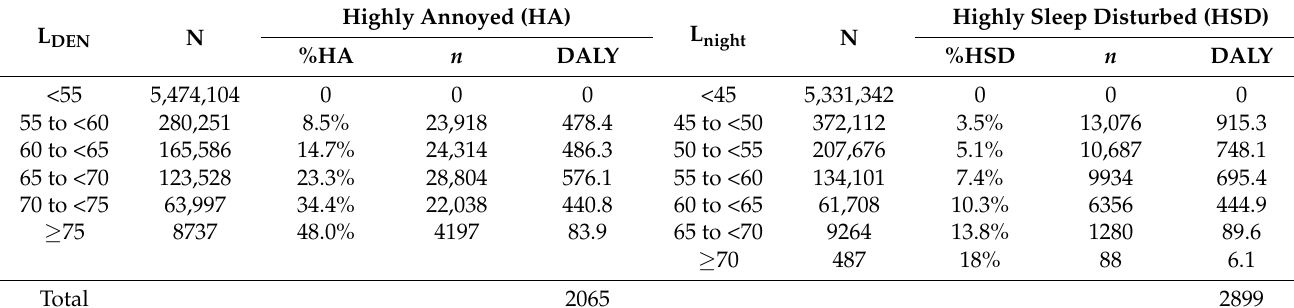
Table 8. The DALYs calculations based on EU Environmental Noise Directive